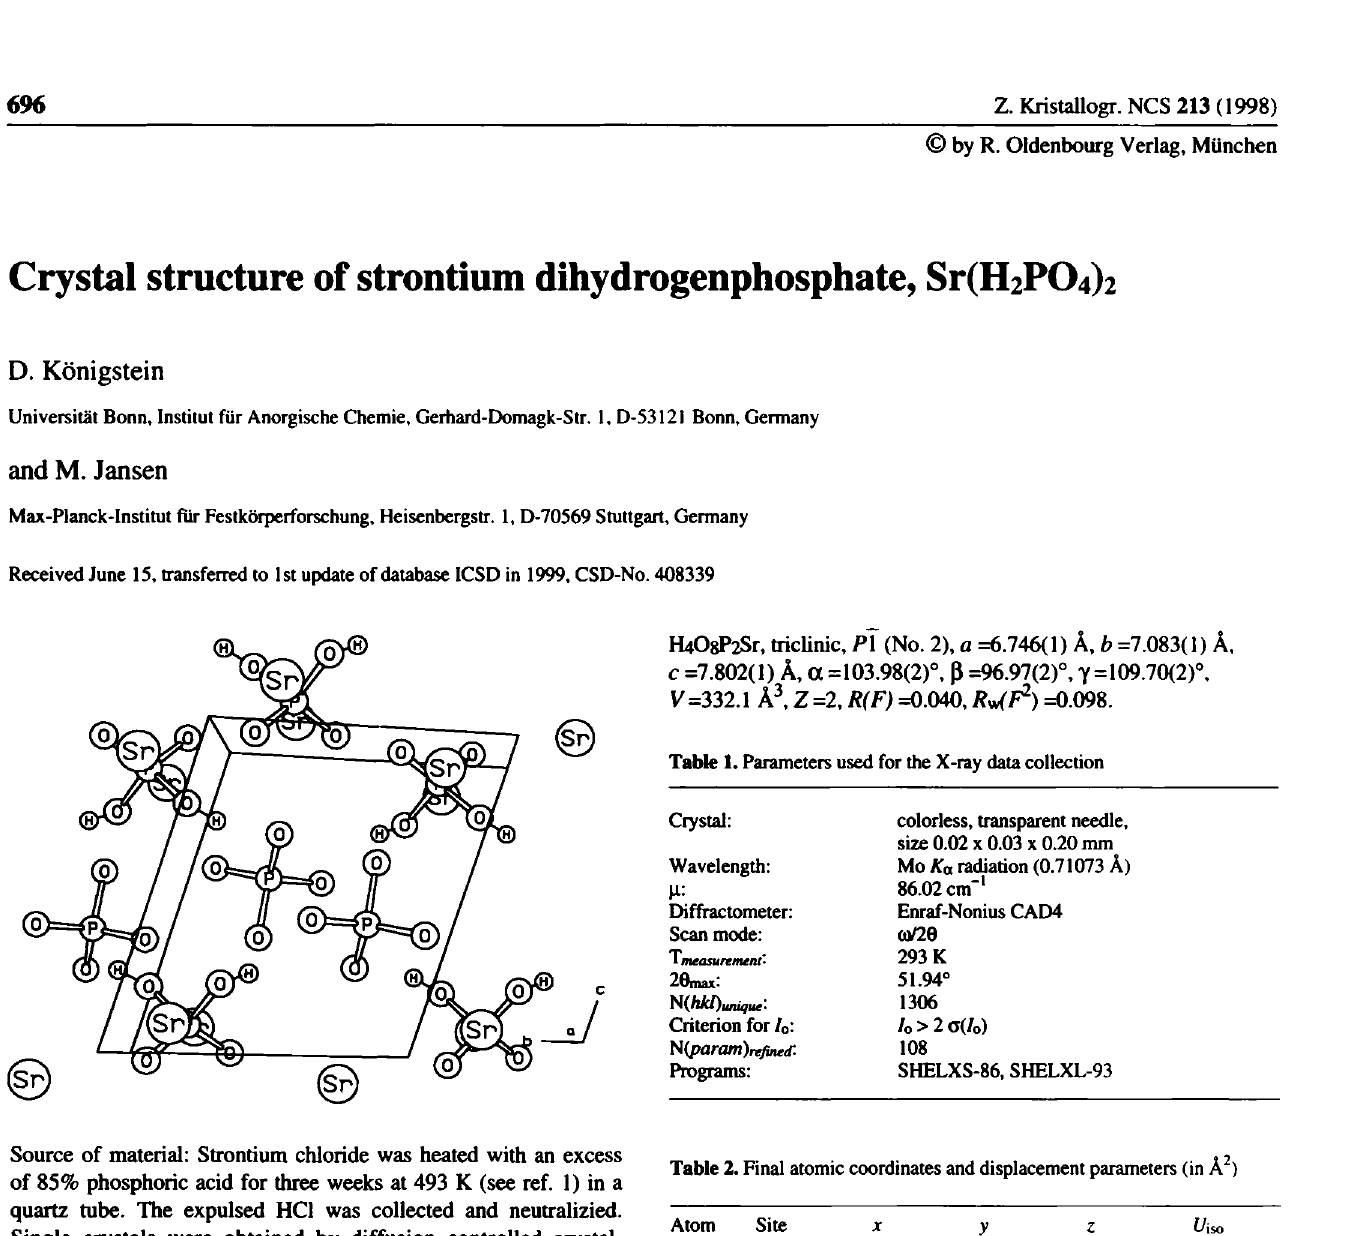
Table 2. Final atomic coordinates and displacement parameters (in Â^)